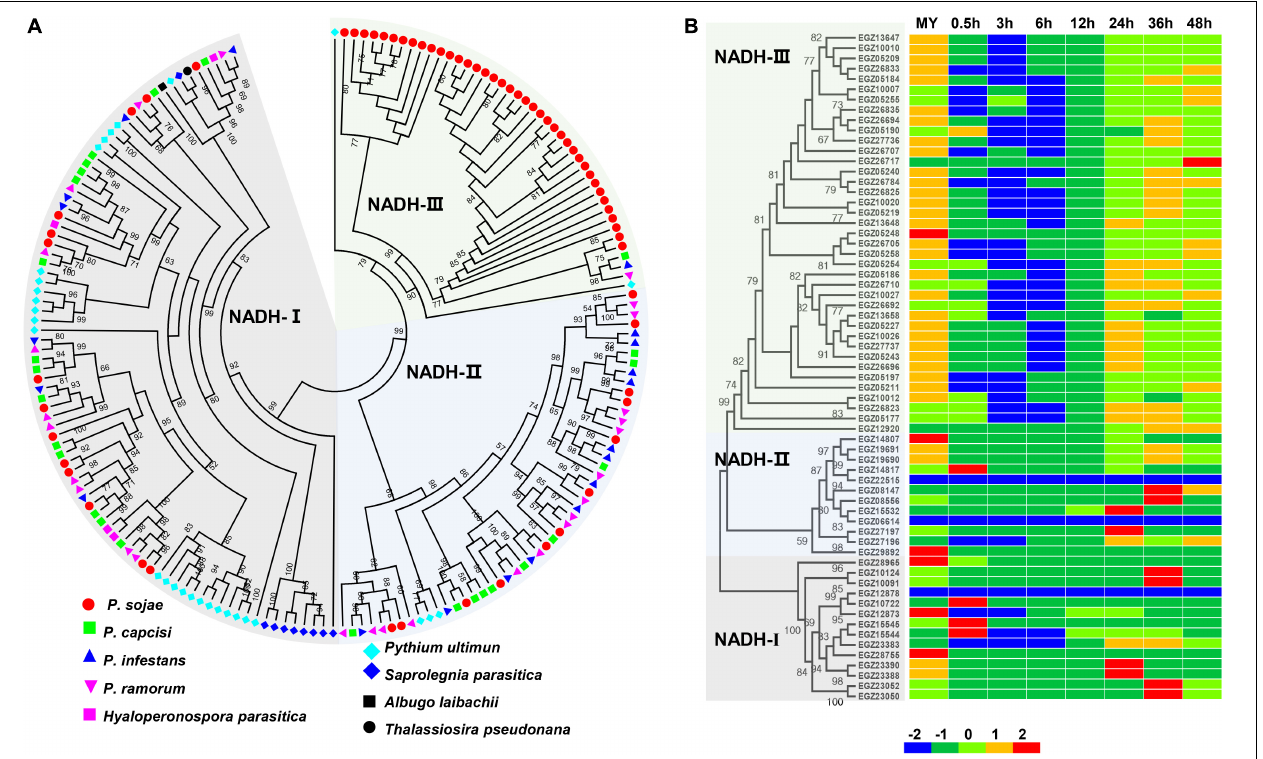
FIGURE 4 | Member expansion of the NADH oxidase gene family in P. sojae . (A) Phylogenetic analysis of oomycete NADH oxidase genes. Nine indicated species were used for analysis. The maximum likelihood tree was constructed using PhyML v3.0 with 1000 bootstrap replicates. Bootstrap values higher than 50% are shown. The accession numbers of sequences used in the analysis are available in Supplementary Table S2 . (B) Phylogenetic analysis and transcriptional patterns of NADH oxidase genes in P. sojae . Z score normalization was applied for transcription levels at all